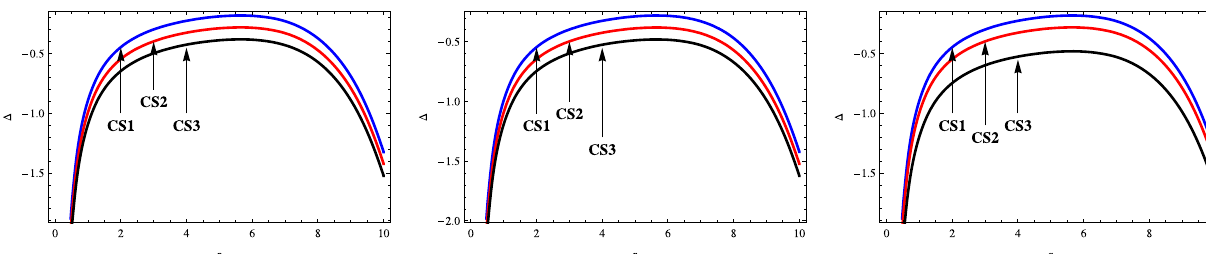
Fig. 6 Variations of (cid:19) versus r (km) with the numerical values of A , B and C from Tables 2, 3 and 4 respectively